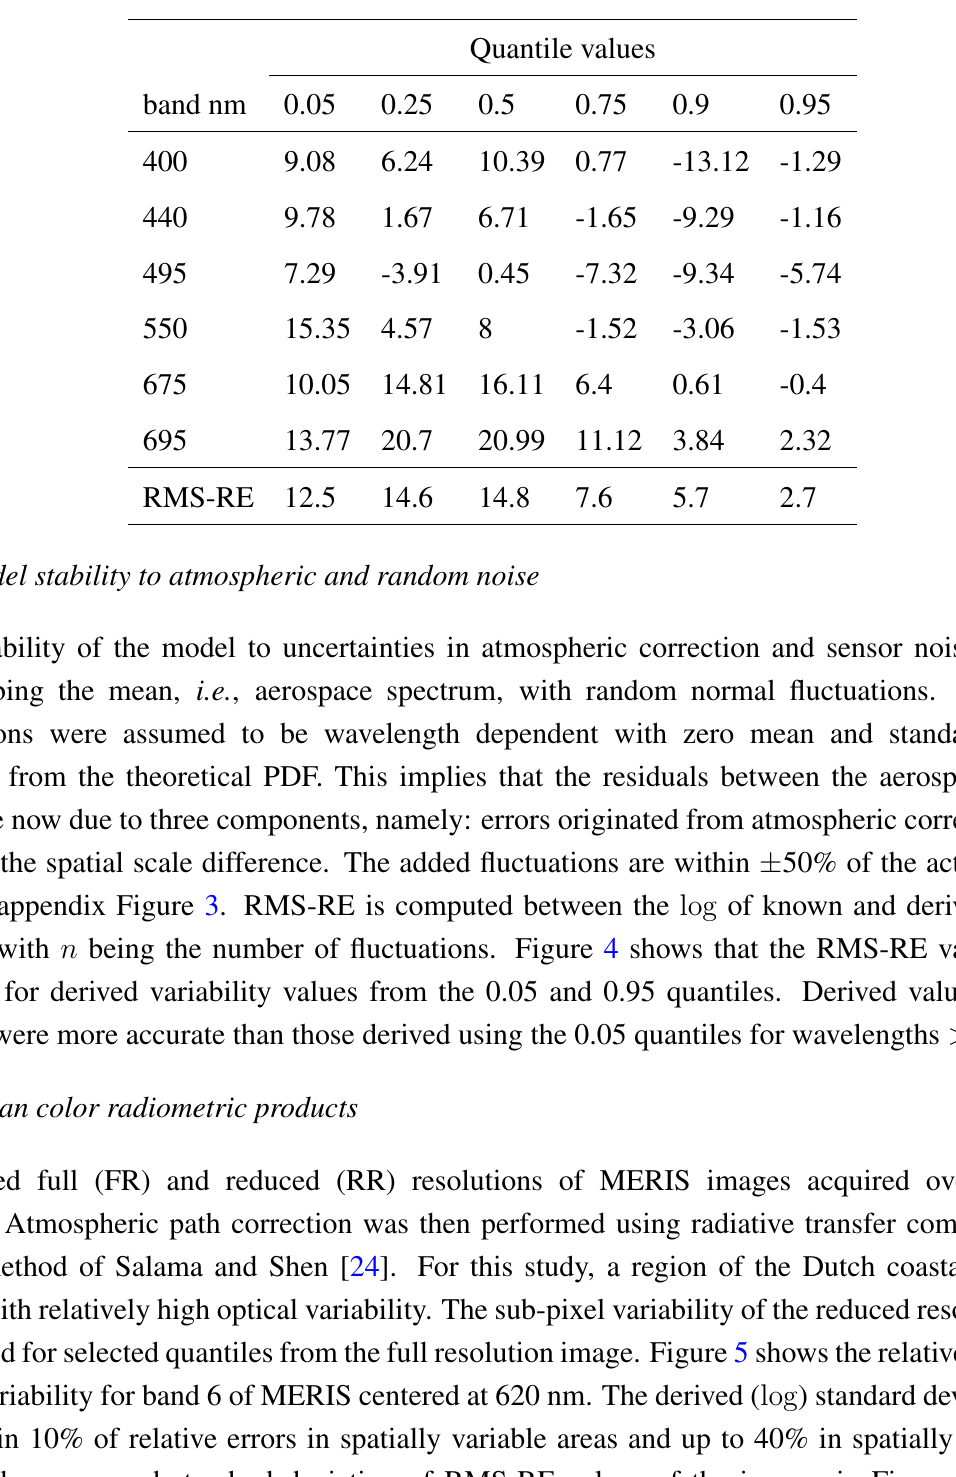
Table 2. Relative errors (%) in derived log σ values of reflectance estimated from different quantile values. Minus values are underestimated. RMS-RE is the root-mean of squared relative error for all